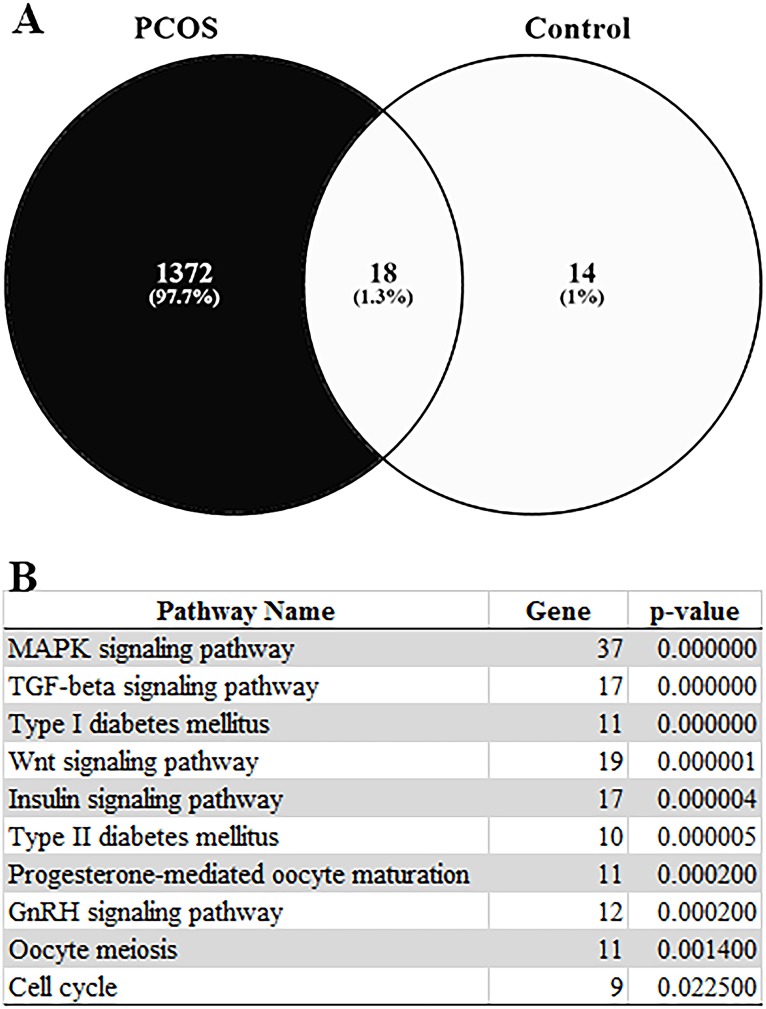
(A) Venn diagram of DEGs for PCOS and control groups obtained from meta-analysis with 1372 genes defined as PCOS specific and 18 genes in common. (B) Pathway enrichment analysis of the 1372 PCOS-specific DEGs.